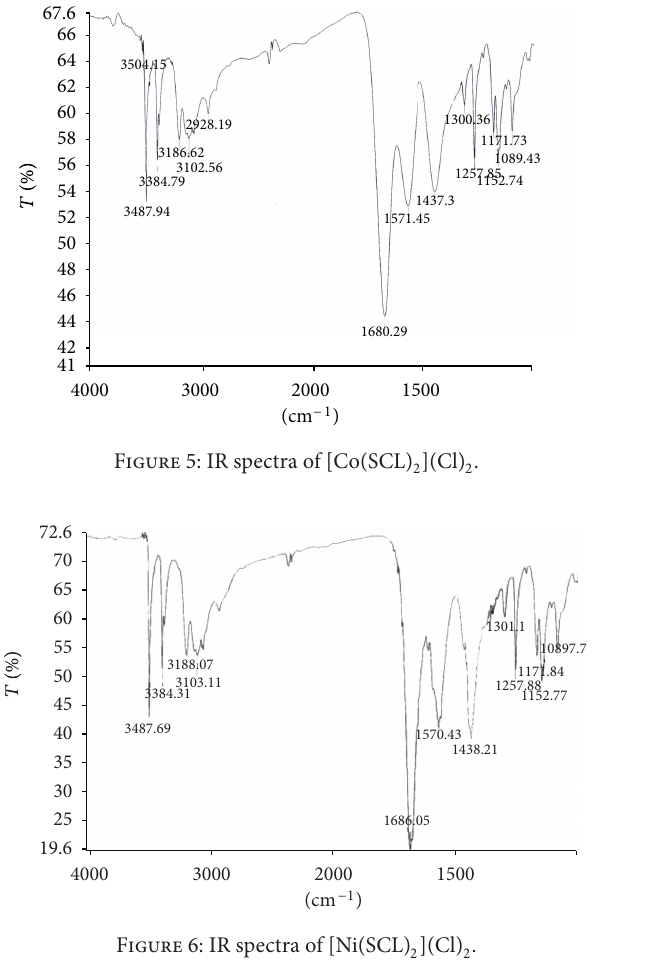
F 8: IR spectra of [Ni(TSCL)